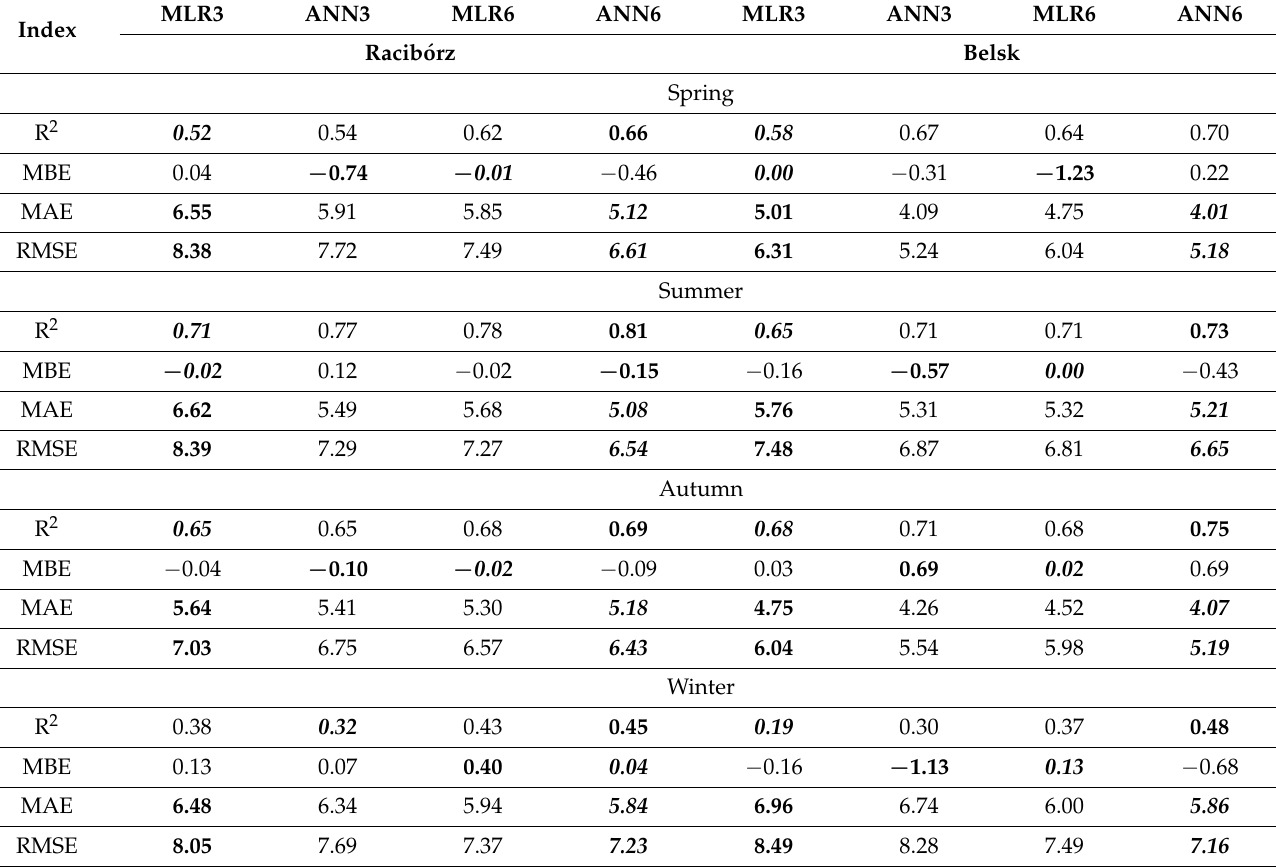
Figure 8. Coefficient of determination (R 2 ) for Racibórz ( a ) and Belsk ( b ) by model and season. MLR3—MLR based on a set of 3 input data, ANN3—ANN based on a set of 3 input data, MLR6—